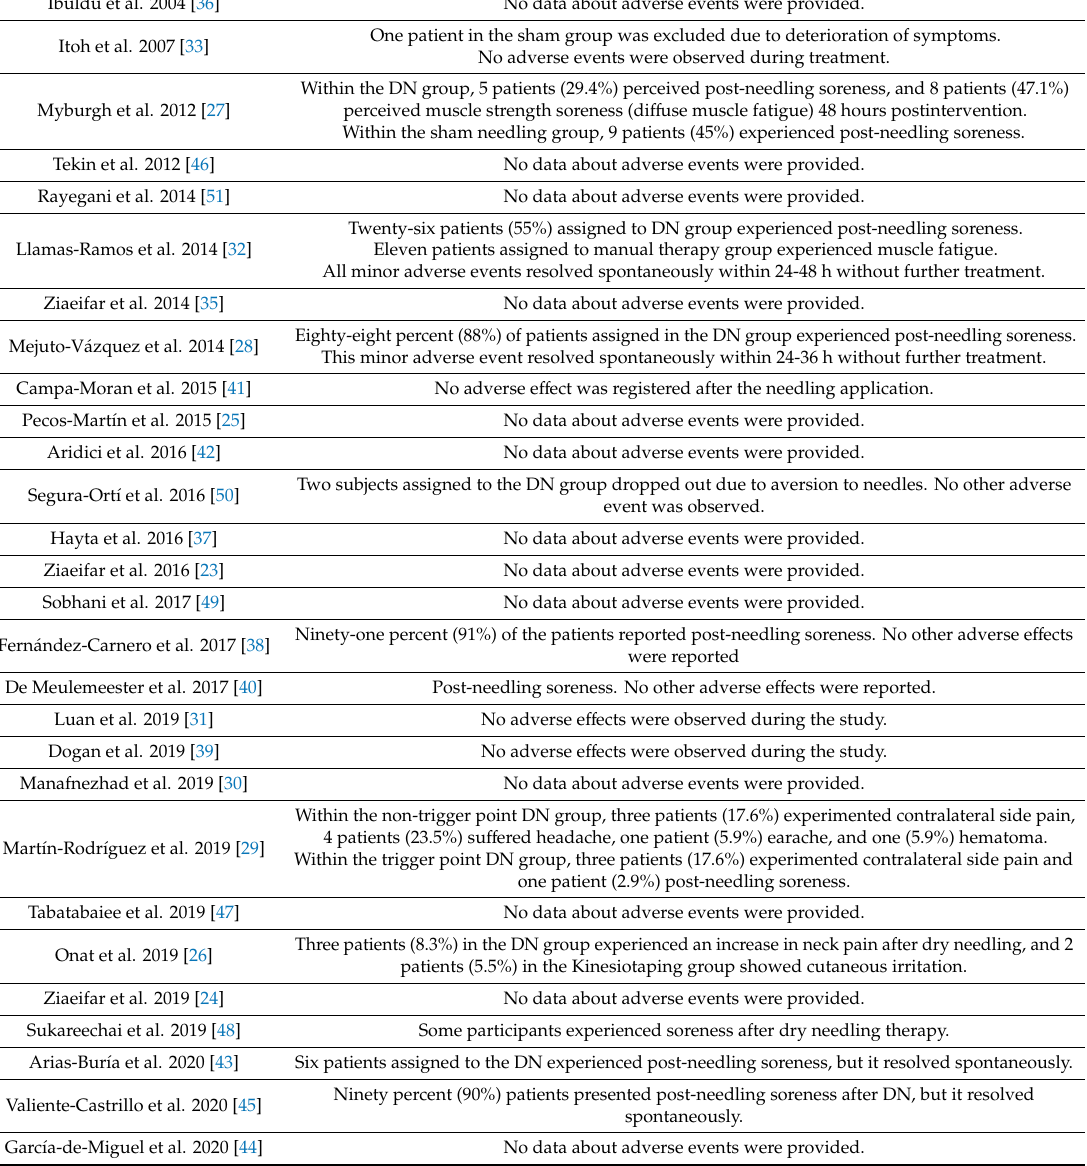
Table 5. Adverse events described in the included